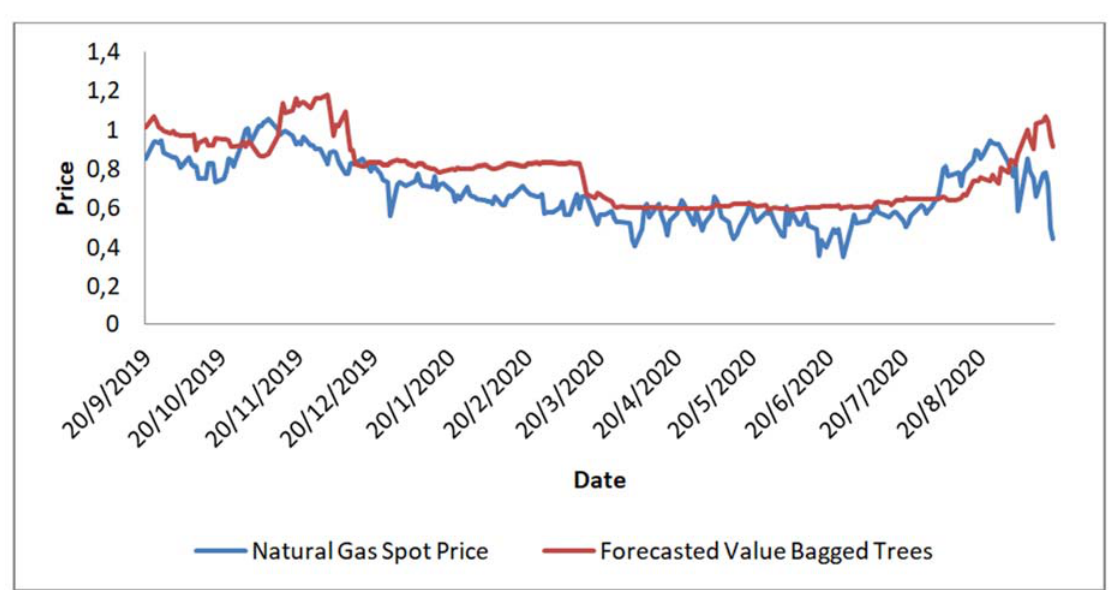
Figure 11. RMSE for t + 10 forecasting.